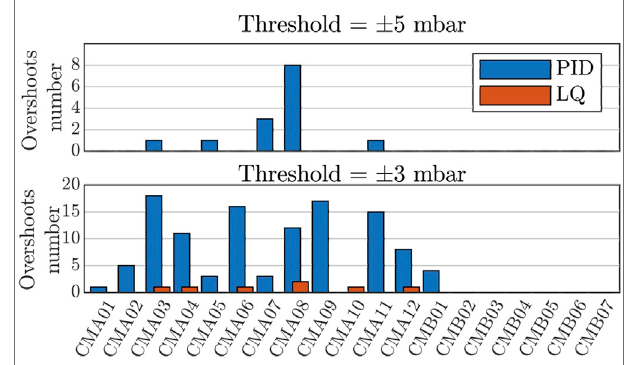
FIGURE 5 | LQ vs. PID pressure overshoot number for one